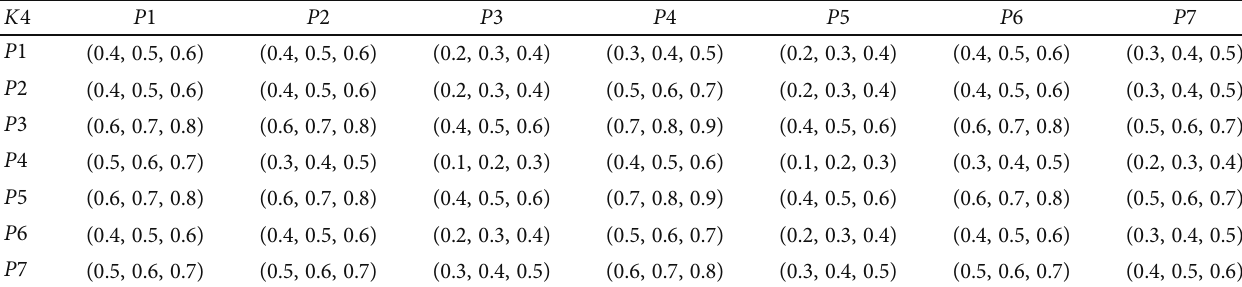
Table 9: Judgment matrix of various indicators of construction technical risk.